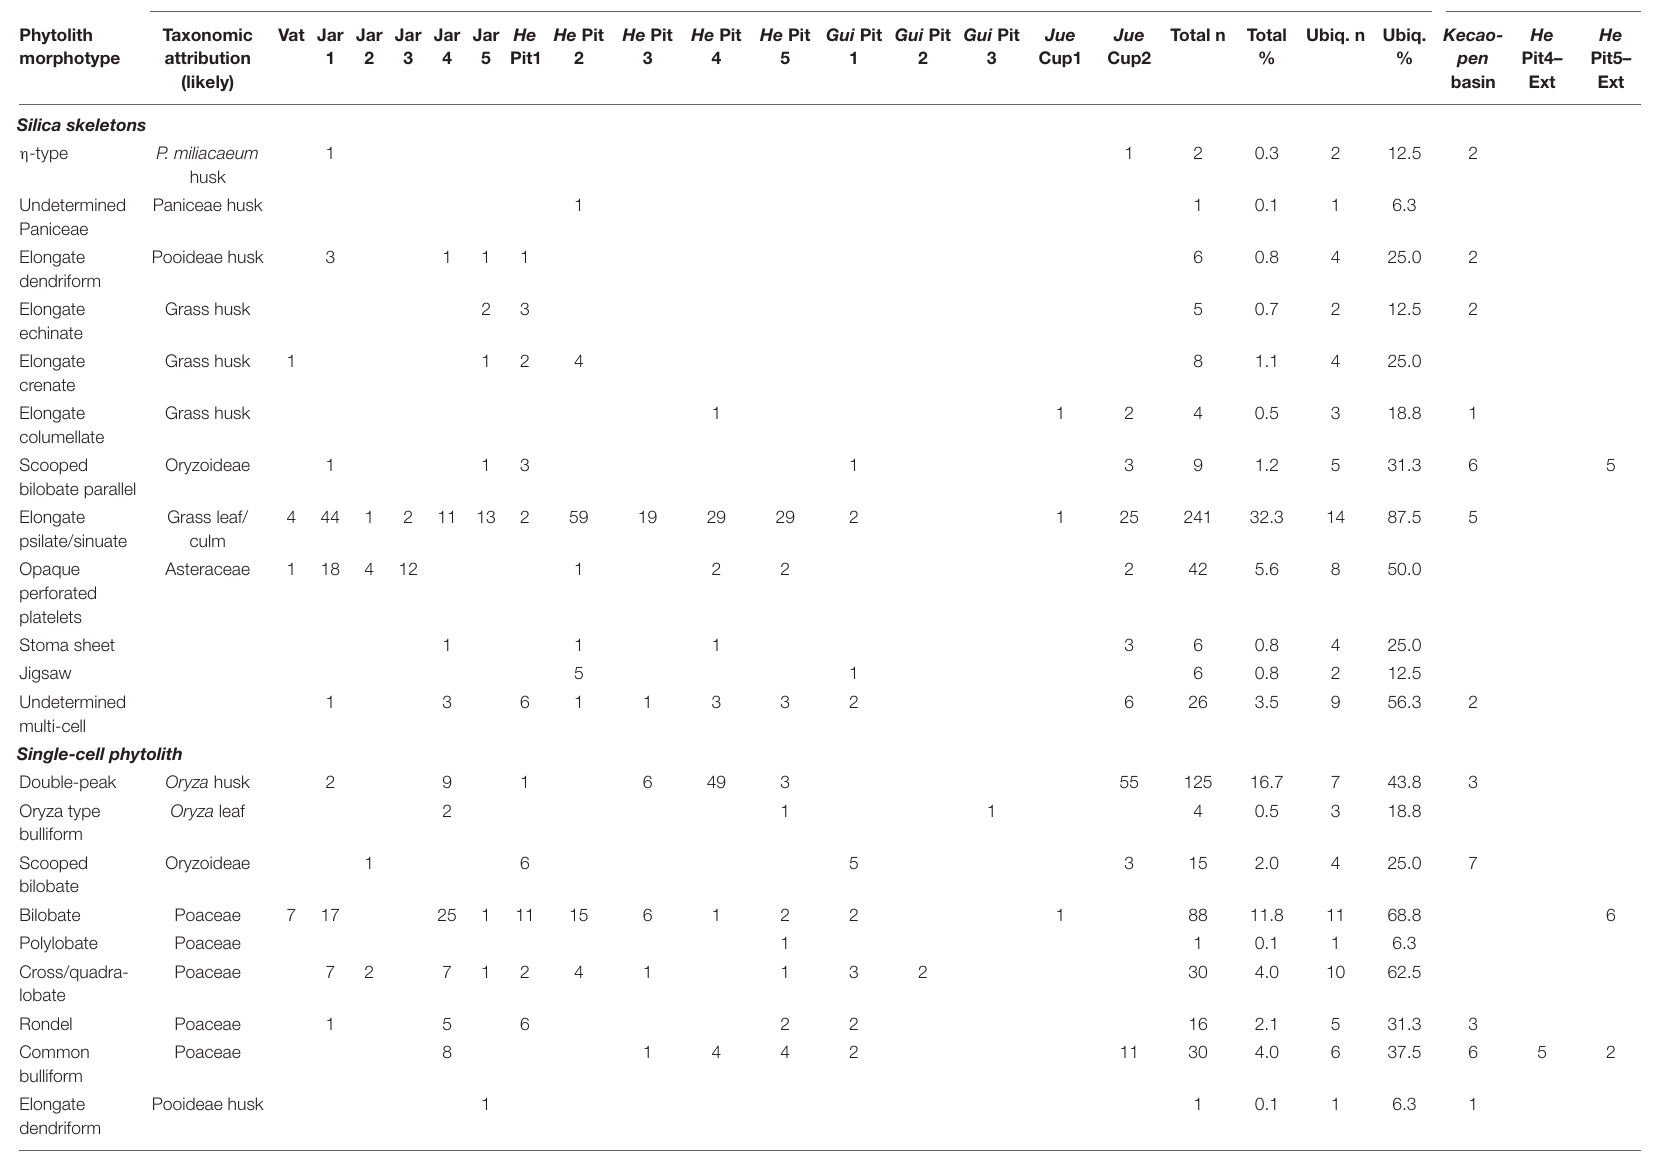
TABLE 3 | Erlitou phytolith